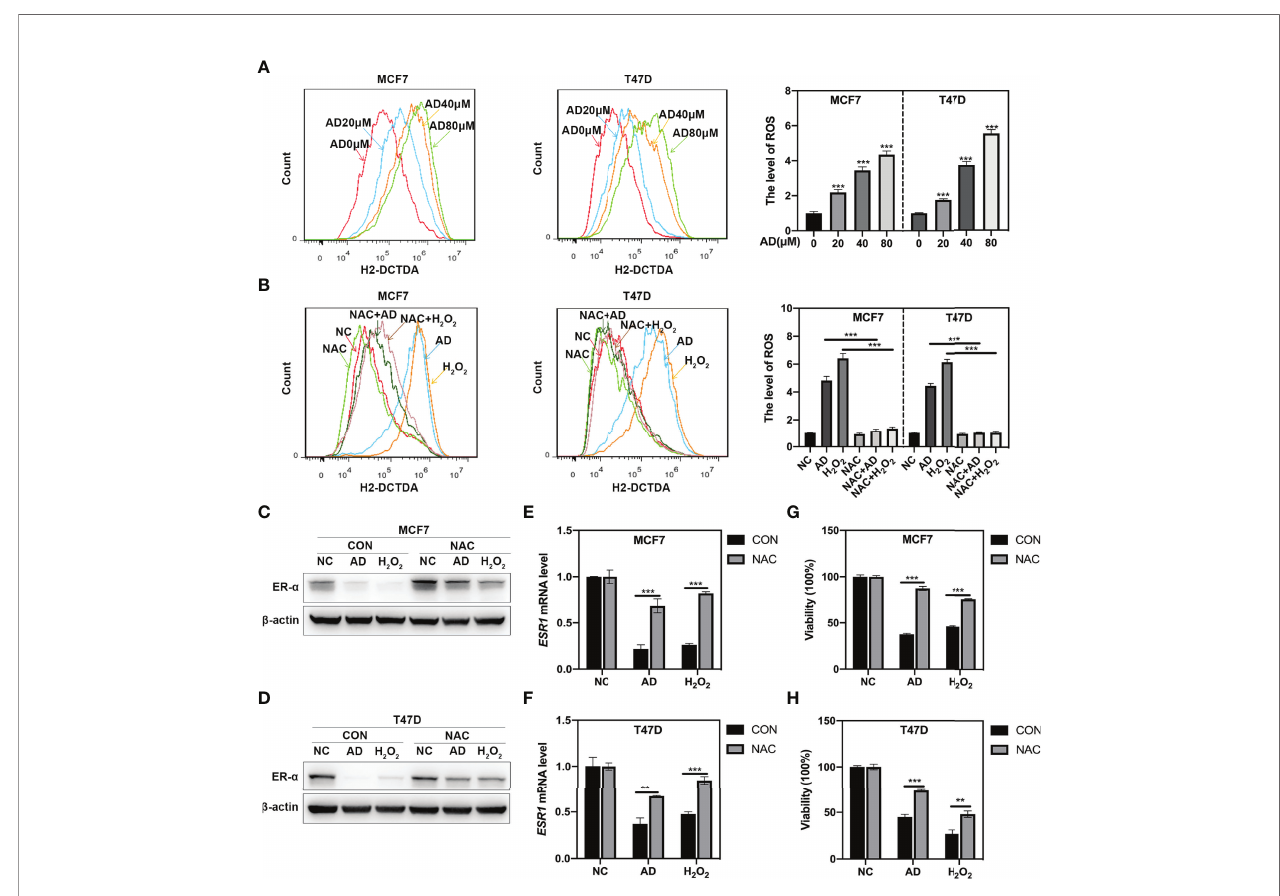
FIGURE 3 | AD inhibits ESR1 transcription via inducing ROS production. (A) AD elevated ROS levels in MCF7 and T47D cells. Cells were treated with various concentrations of AD for 24 h. The level of ROS was determined by H2-DCFDA staining and fl ow cytometry. (B) MCF7 and T47D cells were treated with AD